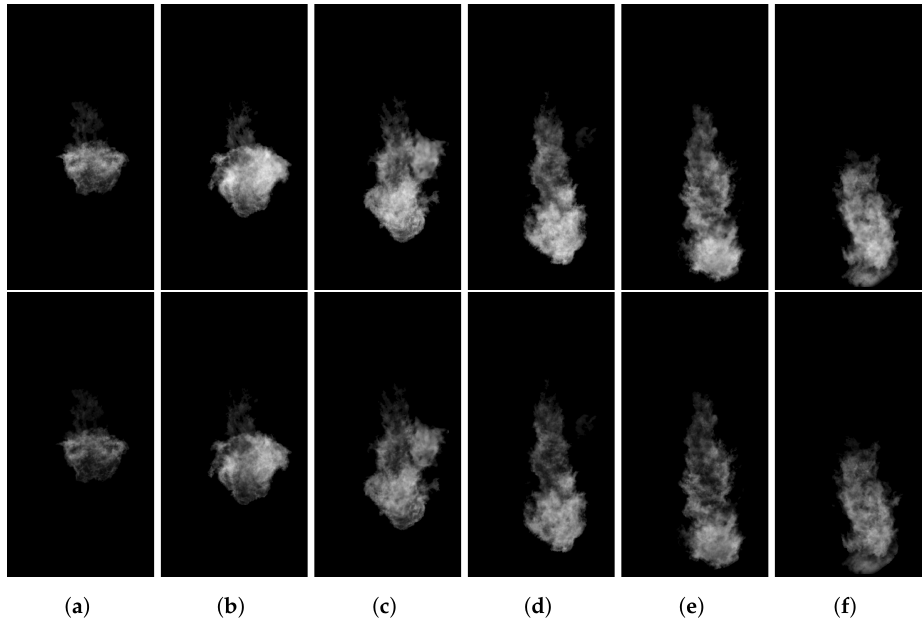
Figure 7. Images corresponding to a test performed with two-color pyrometry. Images were captured in high soot operating conditions and high dynamic range. The images above correspond to the red filter, while those below correspond to the green filter. ( a ) 1500 µ s. ( b ) 1850 µ s. ( c ) 2200 µ s. ( d ) 2550 µ s. ( e ) 2900 µ s. ( f ) 3250 µ